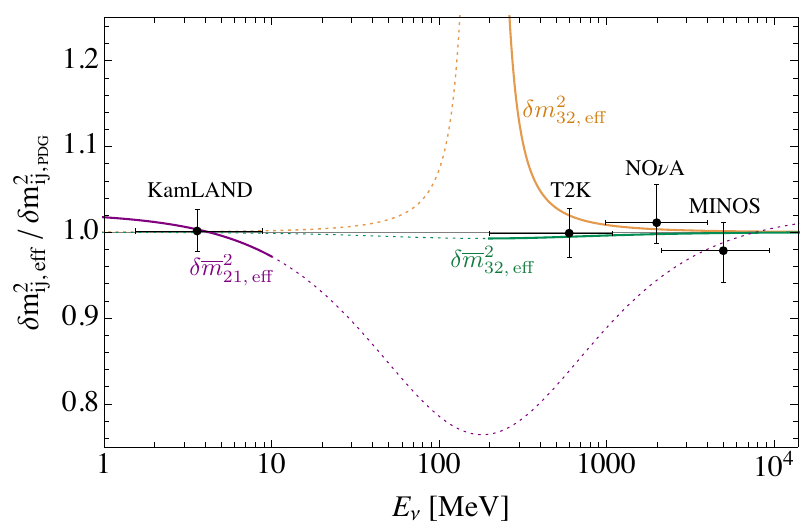
predicted by the full model benchmarks Figure 9 . Effective mass-squared splittings δm 2 ij ,eff B1 and B2 in (3.22) as a function of (anti-)neutrino energy (both benchmarks’ predictions are indistinguishable as displayed in this plot). All effective mass-squared splittings shown have been normalized to the appropriate central value δm 2 reported in the PDG [62]. Solid purple curve: ij, PDG the effective ‘solar’ mass-squared splitting for antineutrinos, δm 2 , expected at KamLAND. Solid 21 ,eff orange (green) curve: the effective ‘atmospheric’ mass-squared splitting for neutrinos (antineutrinos), ( δm 2 ), expected at long-baseline accelerator neutrino experiments running in neutrino δm 2 32 ,eff 32 ,eff (antineutrino) mode. The dotted parts of these curves indicate energy ranges that have not been experimentally probed. The data points with error bars denote recent measurements of δm 2 21 ,eff